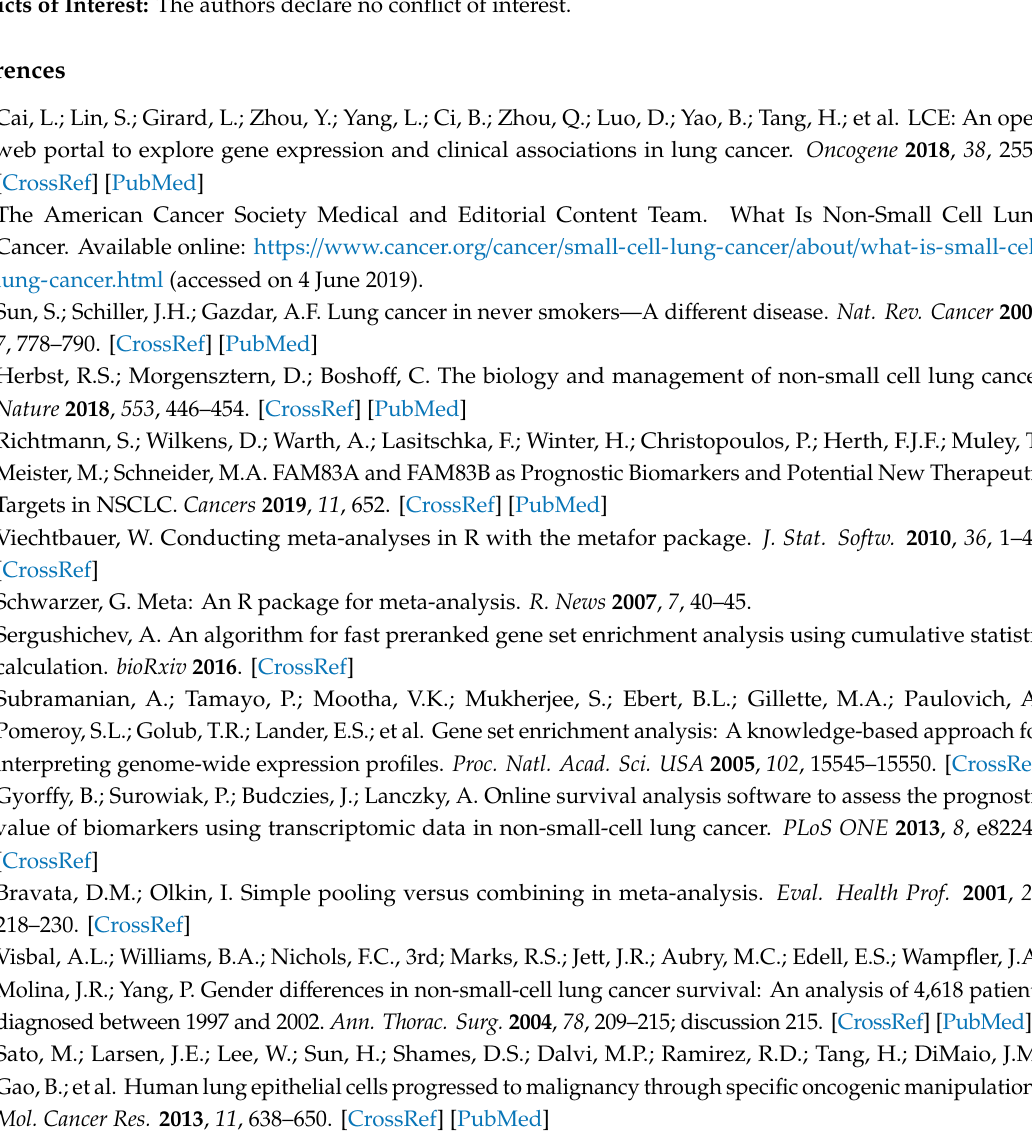
fgsea summary statistics for selected gene sets in Figure S7; Figure S9: Tumor–normal expression di ff erence of FAM83 genes in SQCC and survival association with FAM83 gene expression in ADC; Figure S10: Meta-analysis of recurrence-free survival association for FAM83A and FAM83B and FAM83B expression di ff erence between SQCC and ADC; Table S1: Tumor vs. normal standardized expression di ff erence in ADC, Table S2: Tumor vs. normal standardized expression di ff erence in SQCC, Table S3: Pathway analysis results for tumor vs. normal standardized expression di ff erence in ADC, Table S4: Pathway analysis results for tumor vs. normal standardized expression di ff erence in SQCC, Table S5: Survival association with gene expression in ADC, Table S6: Survival association with gene expression in SQCC, Table S7: Pathway analysis results for survival associations in ADC; Table S8: Pathway analysis results for survival associations in